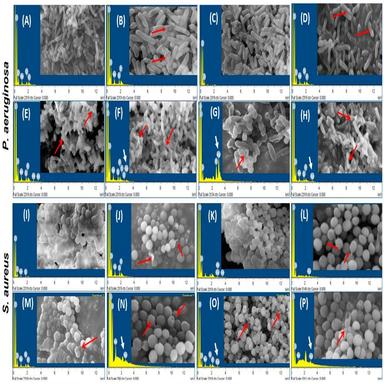
SEM analysis of bacterial cell damage and EDX spectra of metal content in the test samples. P. aeruginosa with different treatments (A–H) and S. aureus with different treatments (I–P). P. aeruginosa and S. aureus cells with untreated (A & I), D2A21 treated (B & J), D2A10 treated (C & K), D4E1 treated (D & L), Positive control (heat treatment in boiling water bath for 30 min) (E & M), nanocomposites D2A21-AgNPs (F & N), D2A10-AgNPs (G & O), D4E1-AgNPs (H & P). The red colored arrows indicating the damage of